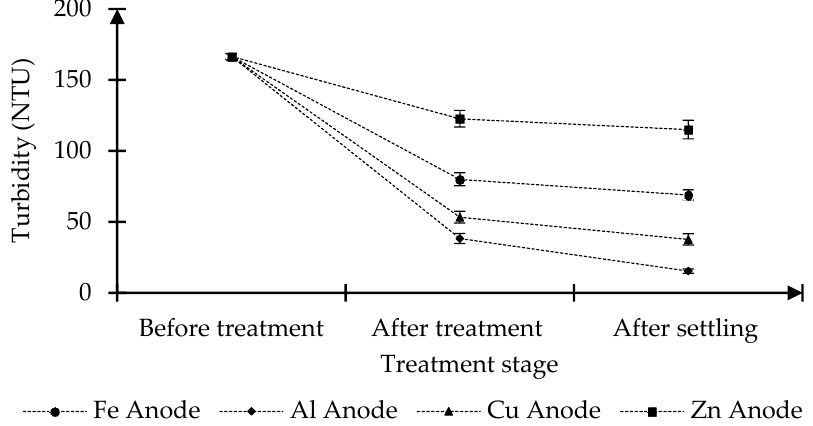
Figure 4. Variation of average turbidity of M. aeruginosa suspensions treated using different anode materials at different treatment stages. Error bars represent the standard deviation ( n = 3).